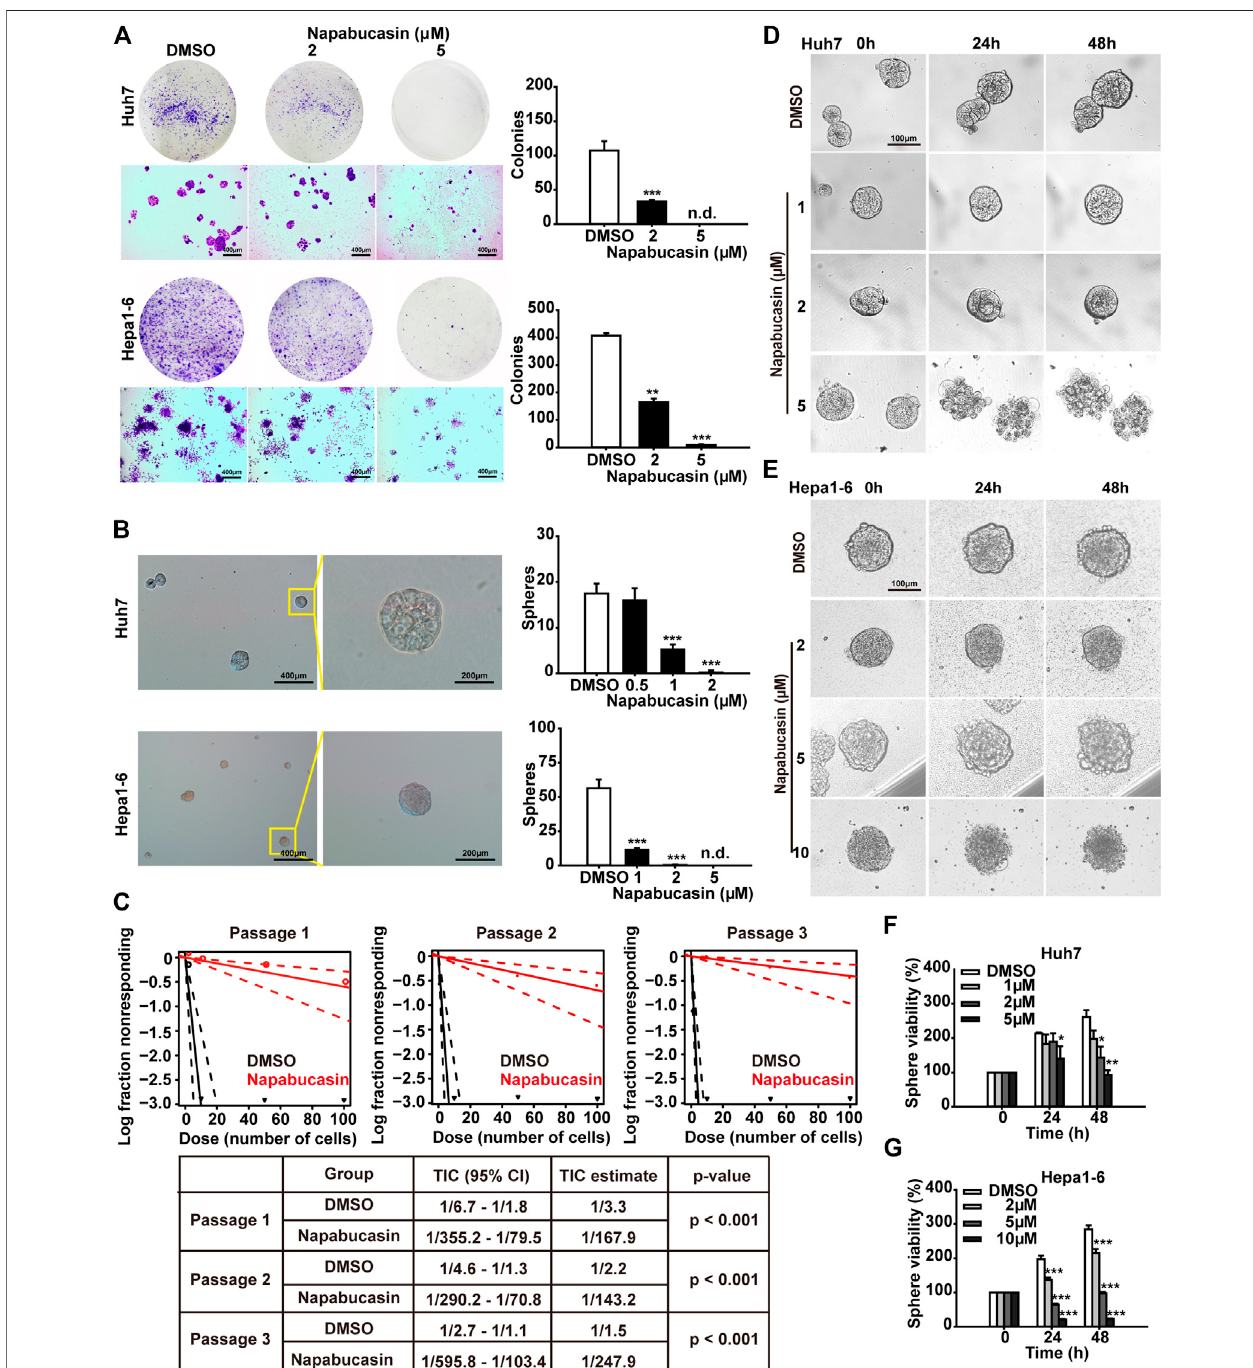
FIGURE 3 | Napabucasin suppresses sphere formation and viability of HCC cells. (A) Representative images ofcrystal violet-stained colonies ( > 100 cells) of Huh7 and Hepa1-6 cells after treatment with DMSO or indicated concentrations of napabucasin. (B) Representative images of multicellular spheroids larger than 80 μ m (left) and quanti fi cation of spheroids derived from DMSO- or napabucasin-treated Huh7 and Hepa1-6 cells (right) . n.d., not detected. (C) Limiting dilution sphere assay of Huh7 cells under DMSO or 1 µM napabucasin from passage one to three. ELDA analysis plot and relative table reporting the TIC percentage and estimation are shown. TIC: tumor-initiating cells. (D) , (E) . Representative real-time images of Huh7 and Hepa1-6 spheroids in the presence of DMSO or napabucasin. (F) , (G) . Viability of the DMSO or napabucasin-treated spheroids after 24 or 48 h. Data are shown as mean ± SD of three independent experiments (* P < 0.05, ** P < 0.01 and *** P <